Question: What type of chart is this?
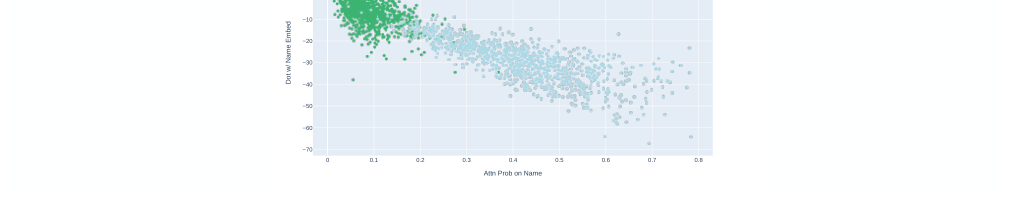
Answer: line